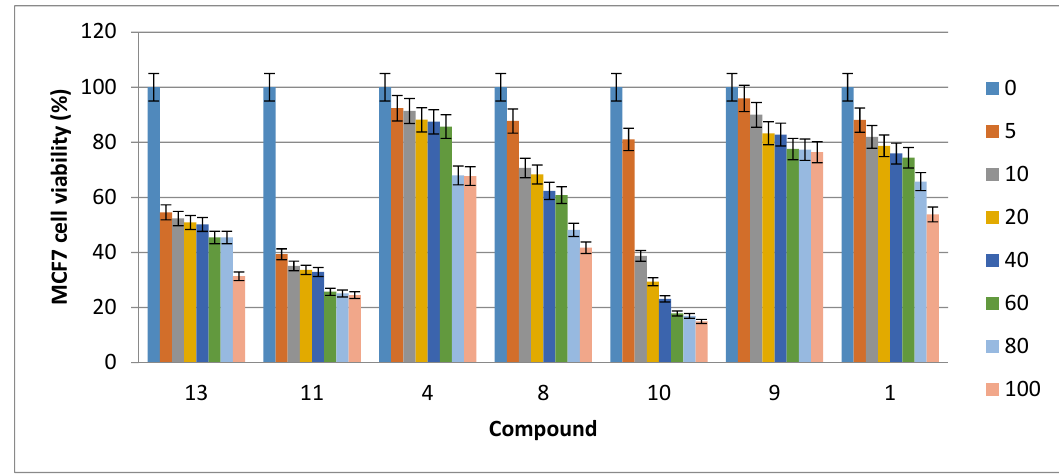
Figure 5. Anti-proliferative activities of compounds against human breast cancer MCF7 cells. The MTT assay was performed three independent times ( n = 3) using different concentrations of the mentioned compounds.